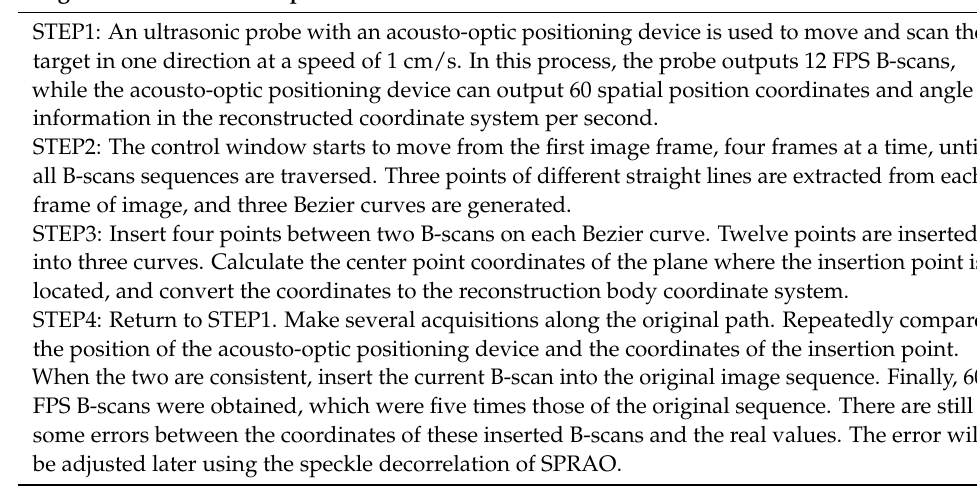
Algorithm 1: Bezier Interpolation of